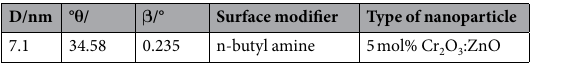
Table 2. The size of nanoparticles obtained by Scherrer equation.